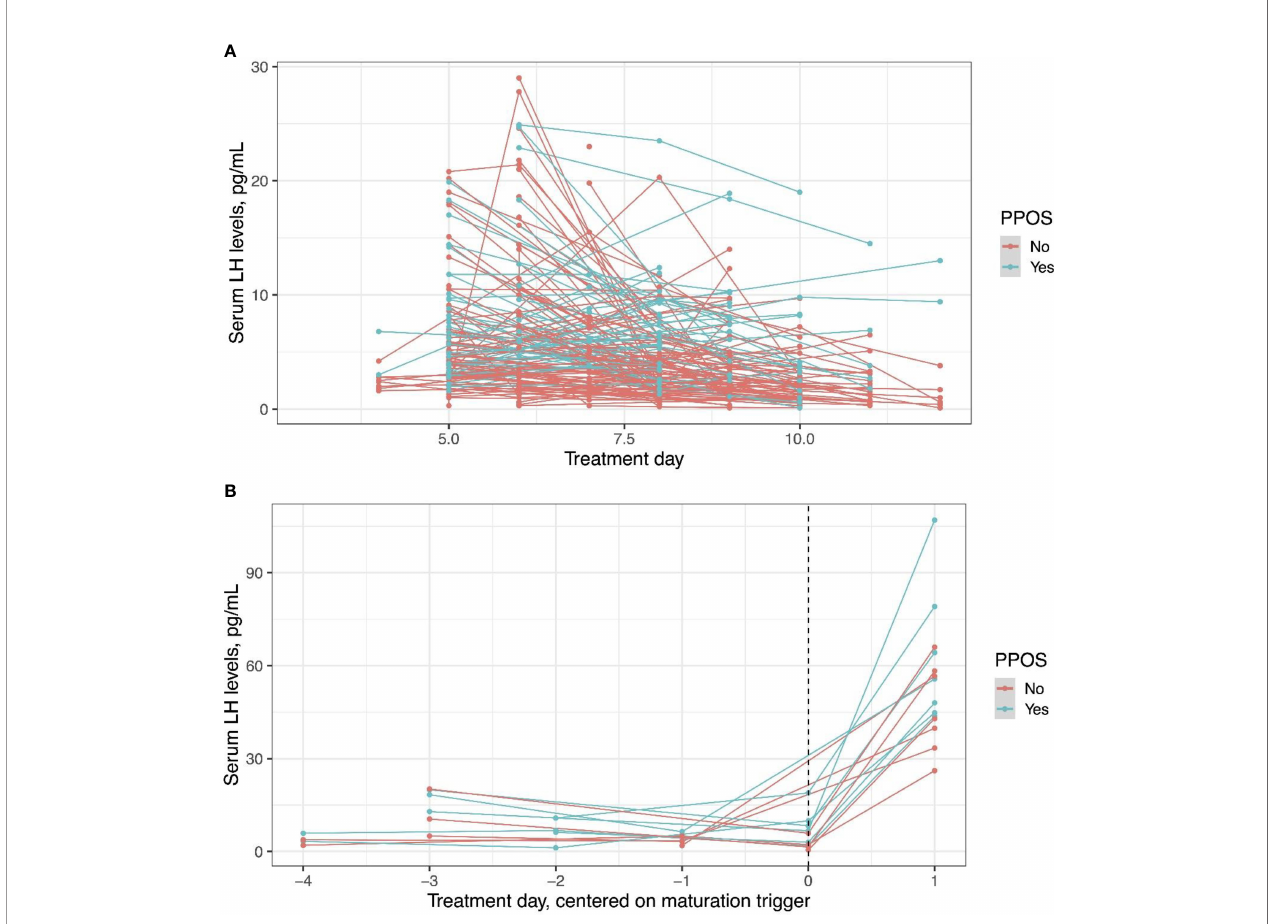
FIGURE 4 | Serum luteinizing hormone levels in progestin-primed and antagonist cycles before the trigger day (A) and after the trigger day (B) . An agonist trigger was associated with higher luteinizing hormone levels throughout the cycle (P < 0.001) and a steeper luteinizing hormone surge in progestin-primed cycles compared with antagonist cycles ( P = 0.02). Dots show individual data points and lines how the trajectory of change for individual